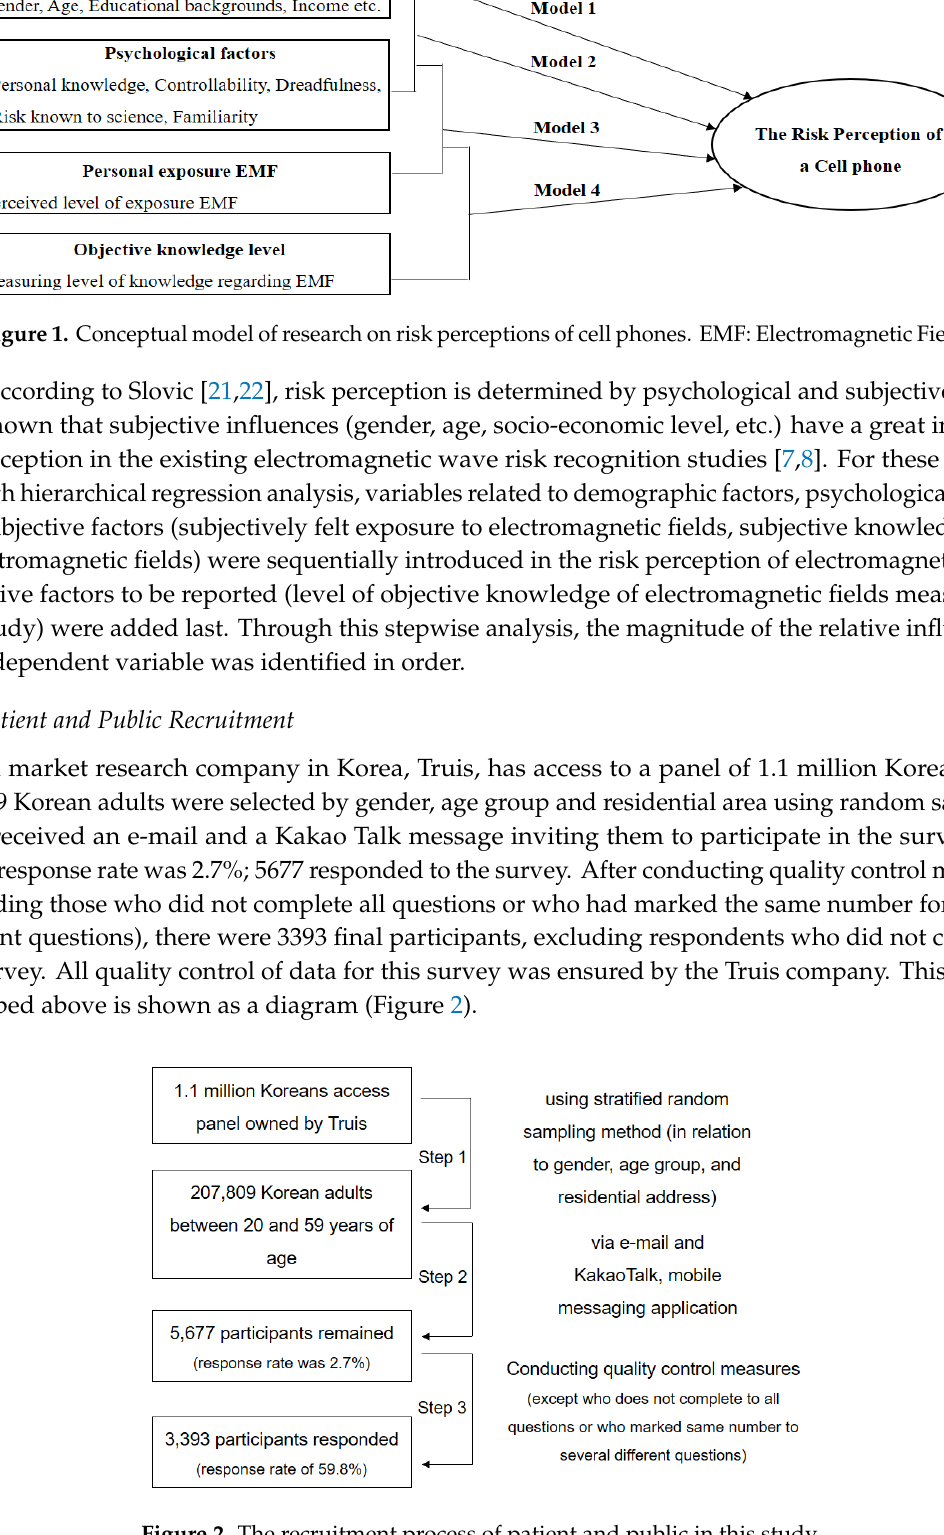
Figure 2. The recruitment process of patient and public in this study.